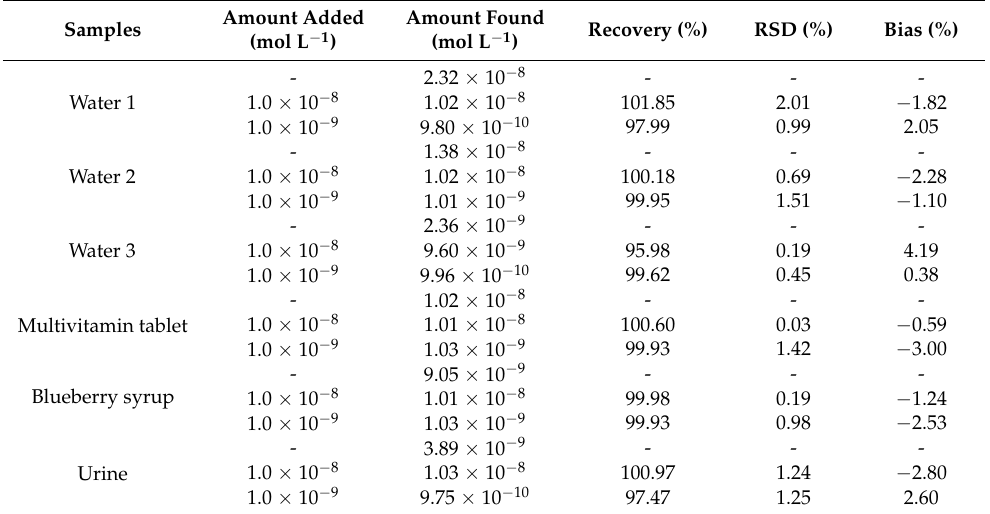
Table 5. Determination of thiamine in food and biological samples using the PIXCoCl/AuNPsnGr sensor.